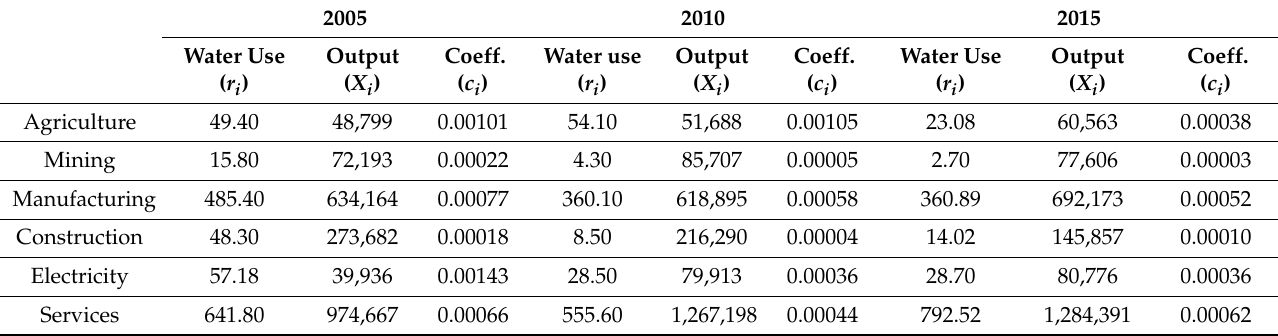
Table 2. Technical coefficients of water usage. Spain (2005, 2010 and